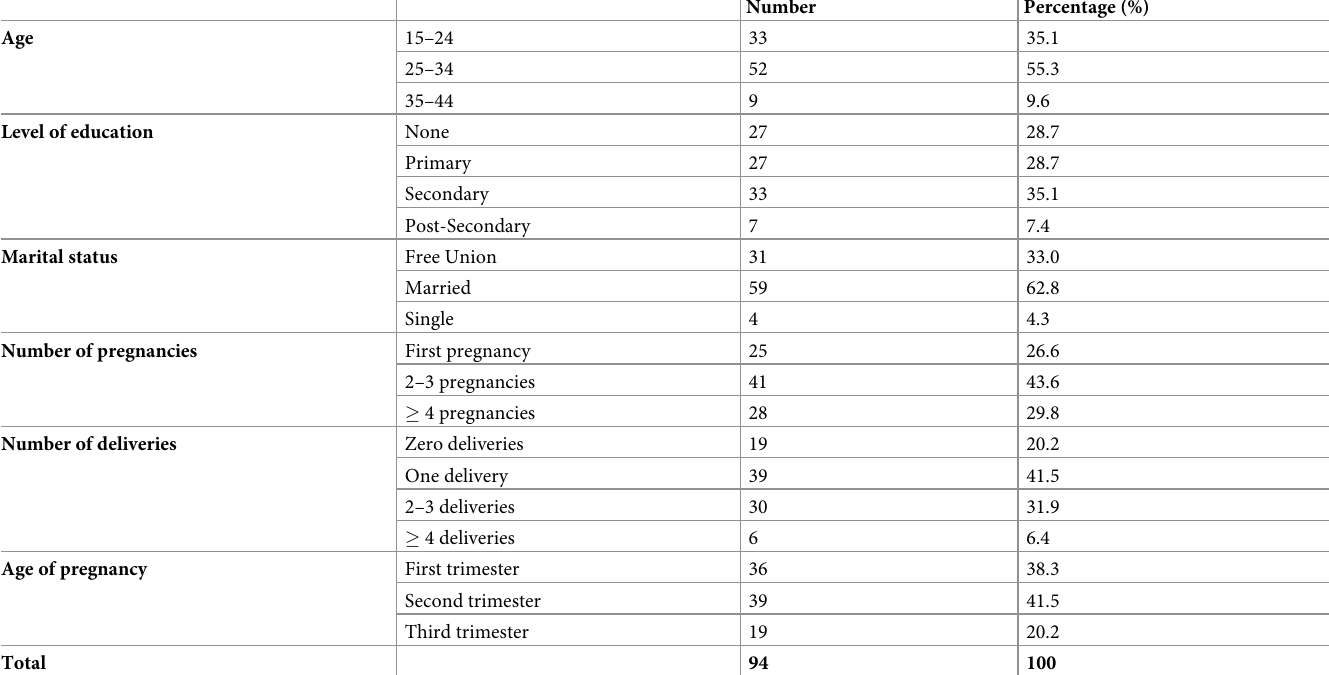
Table 2. Characteristics of pregnant women found to have cough of at least two weeks during antenatal care visits (N = 94).